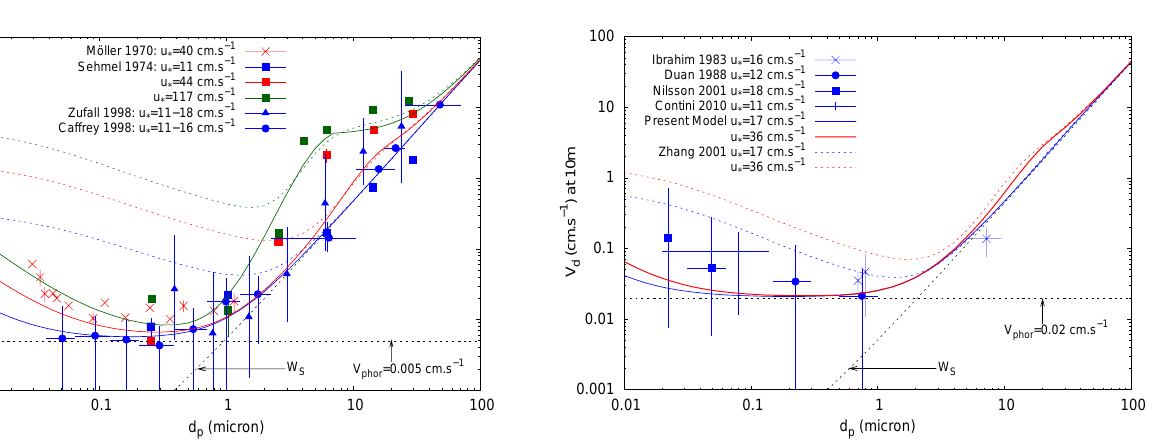
Fig. 7. Deposition on snow and ice surfaces, as measured by Ibrahim et al. (1983); Duan et al. (1988); Nilsson and Rannik (2001); Contini et al. (2010). The present model (plain) and the model of Zhang et al. (2001, dash) are run for u ∗ = 17cms − 1 (blue) and u ∗ = 36cms − 1 (red) for an air temperature of 273 ◦ K (0 ◦ C) and z 0 = 10 − 3 m. All deposition velocities are re-calculated at z R = 10m. The particle density is taken as ρ p = 1500kgm − 3